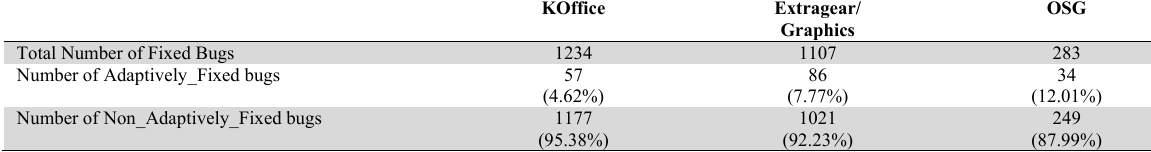
Adaptively_Fixed And Non-Adaptively_Fixed Bugs For The Three Systems Over The Given Time Period